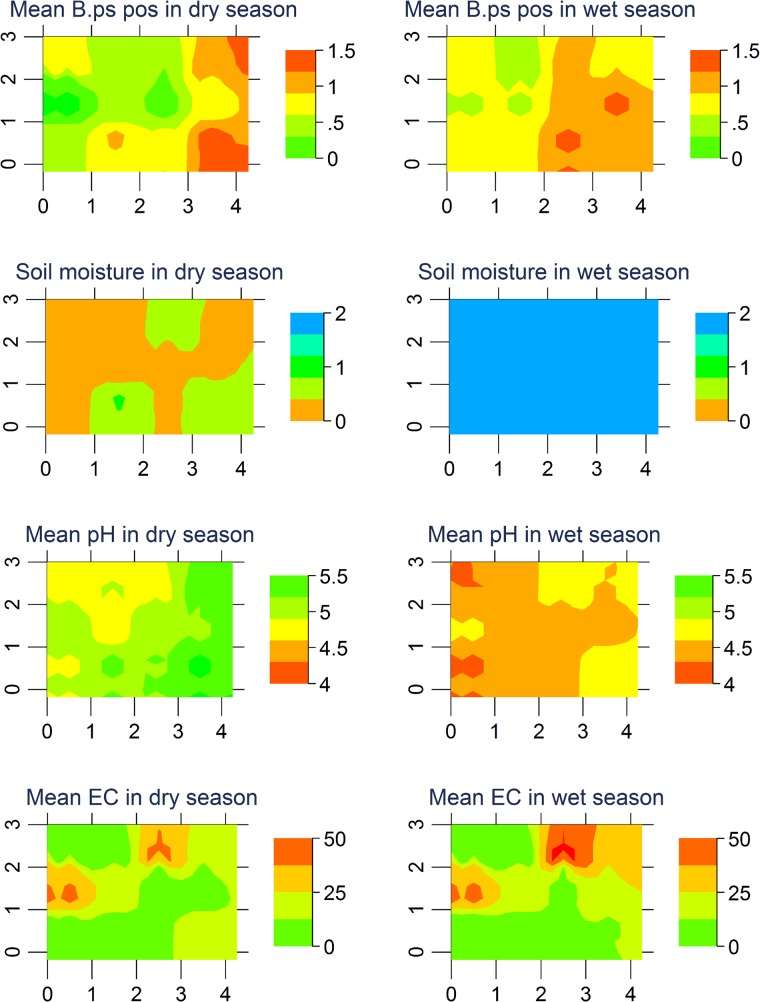
Heat maps for the mean B. pseudomallei occurrence per quadrant for the dry and wet season; mean soil moisture (“0” dry (<4% vsw), “1” moist (4–20% vsw), “2” wet (>20% vsw)), mean pH and mean electrical conductivity EC, i.e. soil salinity (μS/cm).